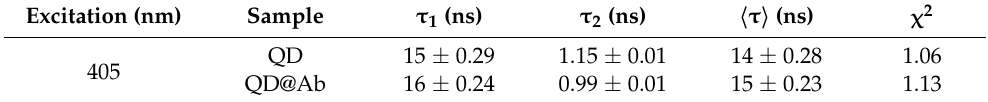
Table 1. Decay Parameters of free QD and QD conjugated with antibodies on paper. Excitation (nm)